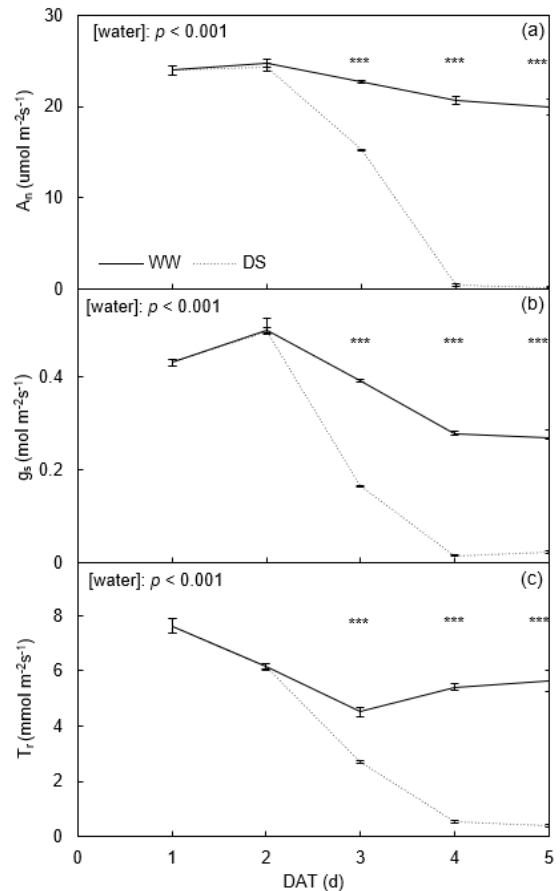
Figure 2. Changes in net photosynthetic rate ( A n ; ( a )), stomatal conductance ( g s ; ( b )) and transpiration rate ( T r ; ( c )) of potato plants grown under well-watered (WW) and drought-stressed (DS) conditions in the field. Error bars indicate standard error of the mean ( n = 5) and asterisks denote significant difference between treatments at p < 0.001. DAT denotes days after onset of treatment. Table 2. Results of a three-way analysis of variance for abscisic acid concentration (ABA) in leaf ( [ABA] leaf ) and xylem ( [ABA] xylem ), leaf water potential ( ψ l ), stomatal density ( SD ), stomatal Table 1. Results of the linear-plateau regression of leaf net photosynthesis rate ( A n ), stomatal con- ductance ( g s ) and transpiration rate ( T r ) to the reduction in fraction of transpirable soil water ( FTSW ) for the potato plants grown in the greenhouse cells. Data are shown in Figure 1.